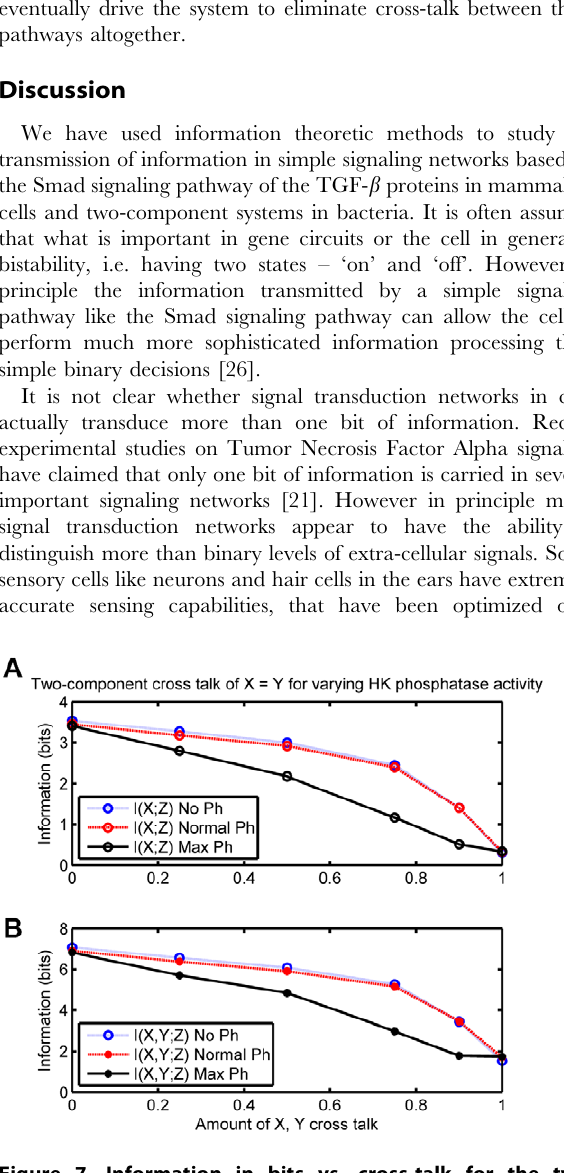
Figure 7. Information in bits vs. cross-talk for the two- component model, with equal cross talk and various HK phosphatase activities. ( A ) Partial mutual information and ( B ) total mutual information. The red line shows the default phosphatase activity where strength of phosphatase activity toward the non-cognate RR varies with level of cross talk. The blue line shows a system where the HK has no phosphatase activity. The black line shows where the strength of phosphatase activity toward the non-cognate RR is maximum regardless of the level of cross-talk.